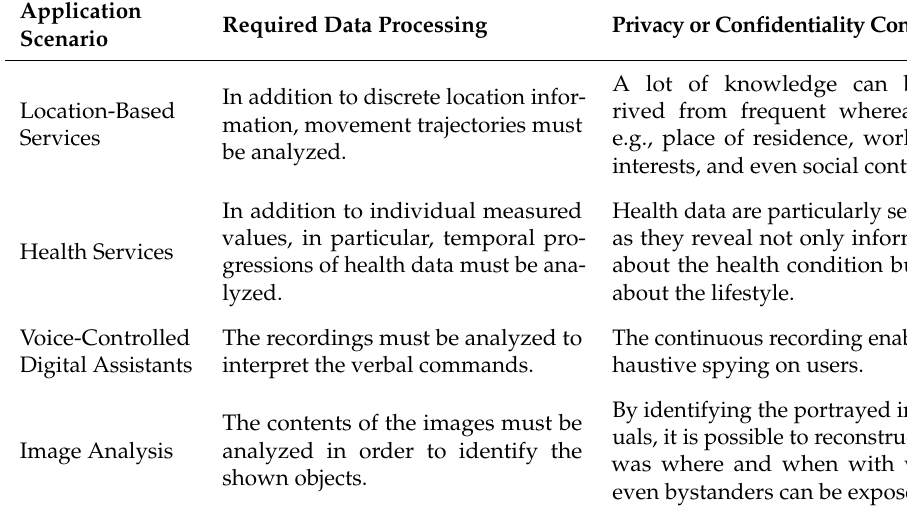
Table 1. Synopsis of the Main Findings Regarding the Processing of Data in Smart